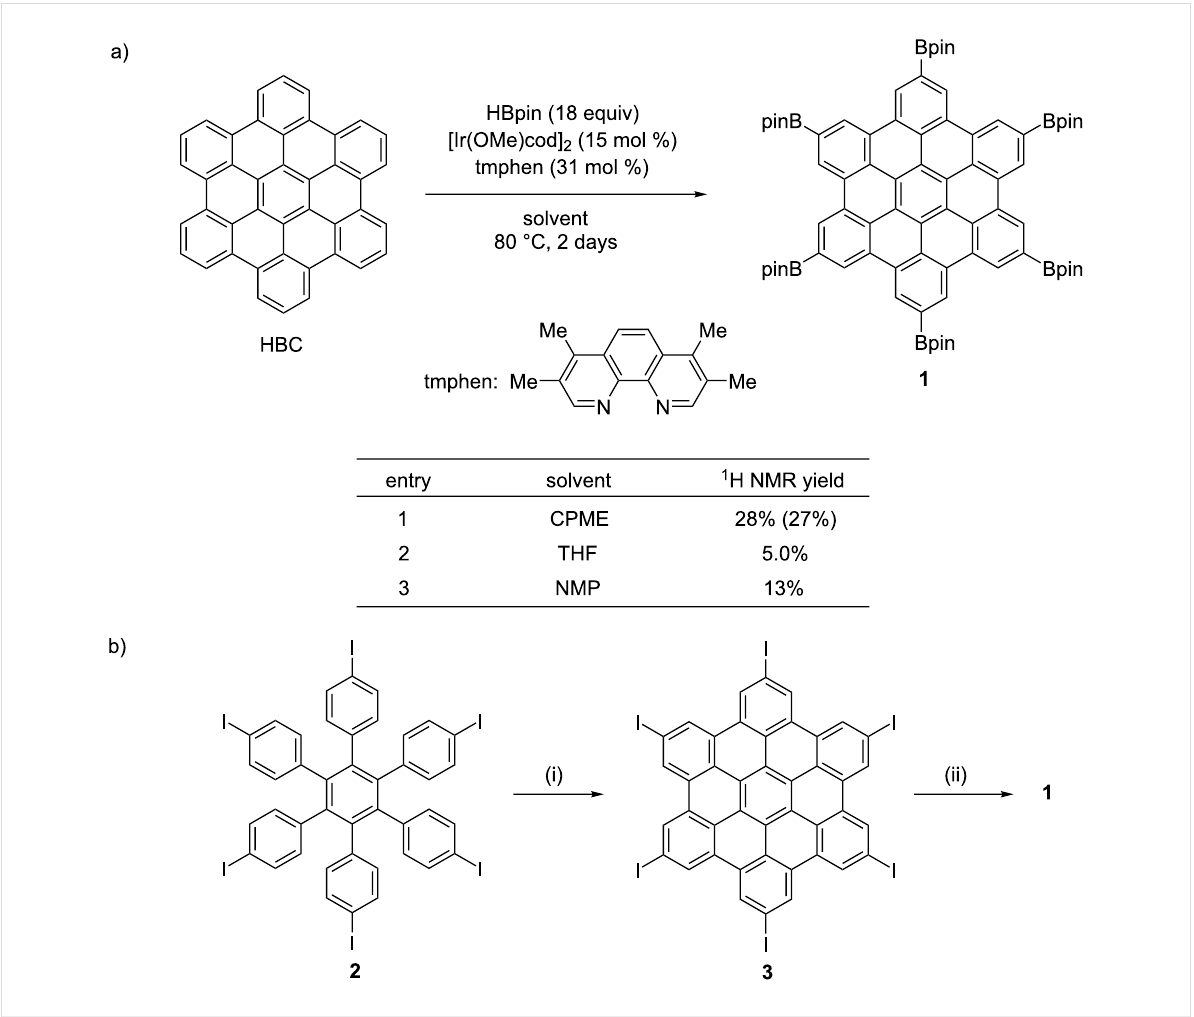
Figure 2: Synthesis of hexaborylated HBC 1. (a) Solvent screening of six-fold C–H borylation of unsubstituted HBC. 2,3,4-Trimethoxybenzaldehyde was used as an internal standard to estimate the yield of 1 . The yield in parentheses is the isolated yield of 1 . (b) Stepwise synthesis of 1 via Miyaura–Ishiyama borylation. Reaction conditions: (i) FeCl 3 (32 equiv), CH 3 NO 2 /CH 2 Cl 2 , rt, 21 h; (ii) B 2 pin 2 (10 equiv), Pd(dppf)Cl 2 (50 mol %), KOAc (6.2 equiv), toluene/DMF (1:1), 80 °C, 18